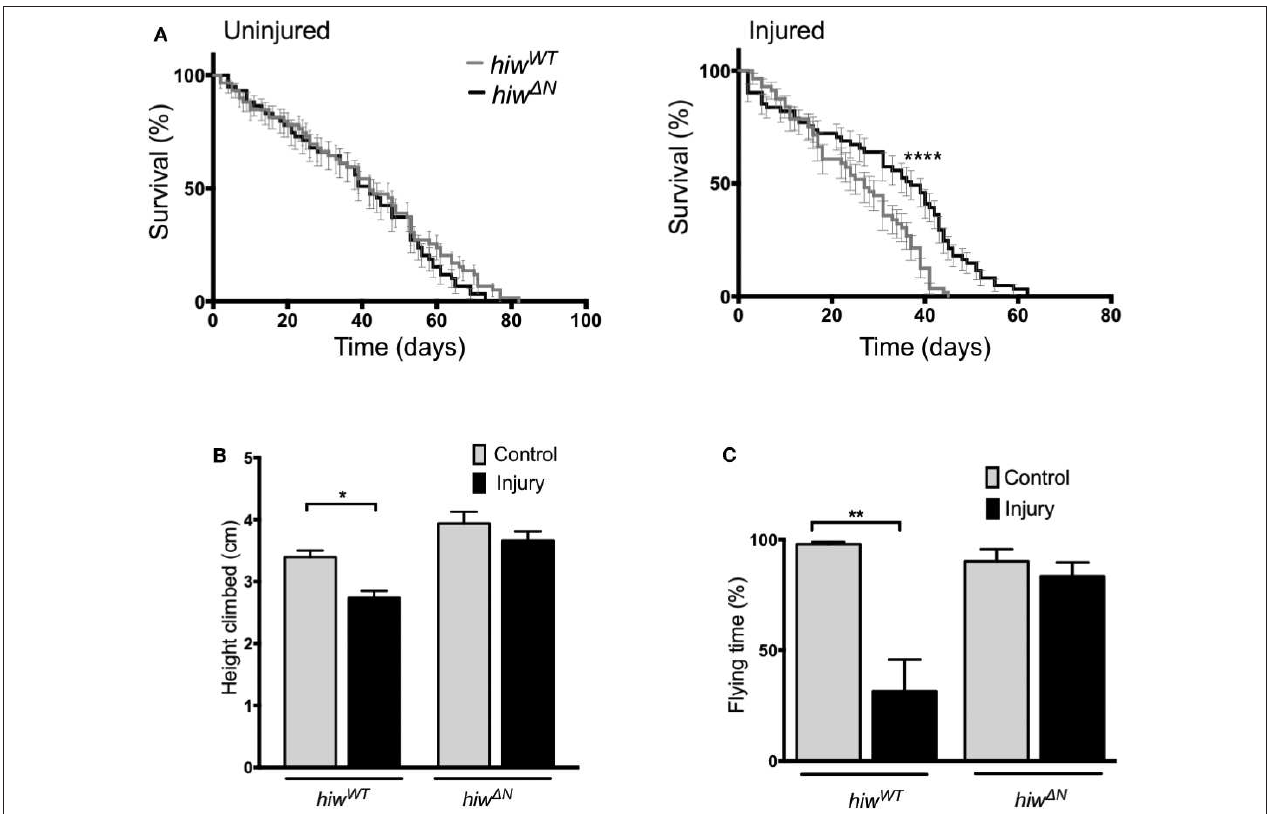
FIGURE 1 | Long-term mortality, climbing, and flying ability are relatively preserved in highwire mutants. (A) Mortality rates over lifetime of flies in hiw 1 N and hiw WT flies. n = 6 vials of 20-35 flies per condition. Statistical analysis was with Log-rank test. **** p ≤ 0.0001. (B) Reduction in climbing ability compared to baseline in injured versus uninjured hiw 1 N and hiw WT flies at 45 days post injury. n = 6 vials of 35 flies per condition. Statistical analysis was with two-way ANOVA test. * p ≤ 0.05. (C) Percentage of time spent in flight over a 30s period in injured versus uninjured hiw 1 N and hiw WT flies at 7 days post injury. n = 10-12 per condition. Statistical analysis was with two-way ANOVA test. ** p ≤ 0.01. Error bars show standard error of the mean for all